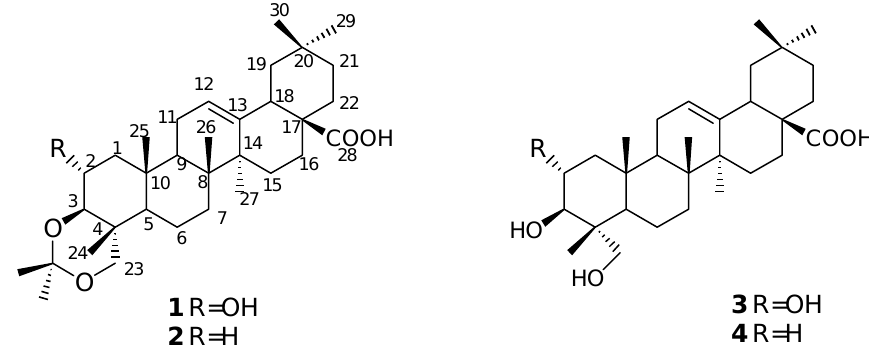
Figure 1. The structures of compounds 1–4 from Stachyurus himalaicus var. Himalaicus.